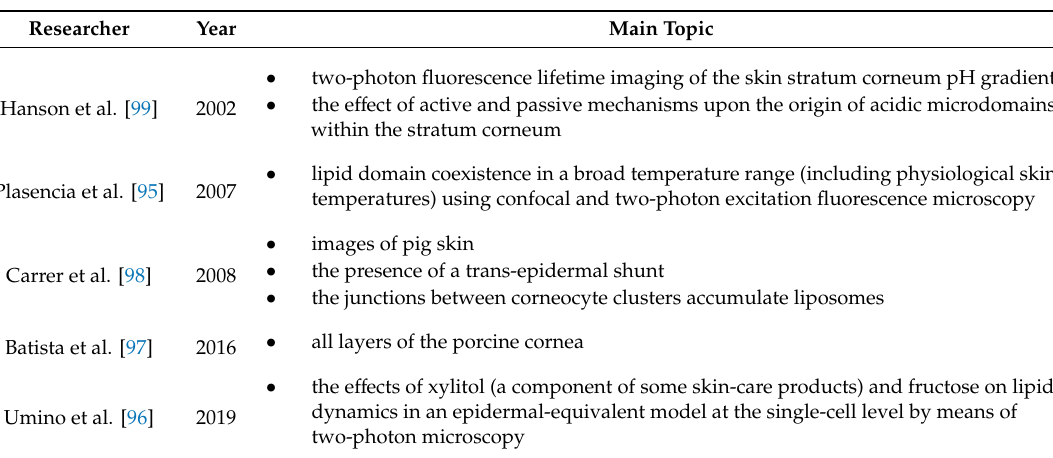
Table 4. Two-photon microscopy results.